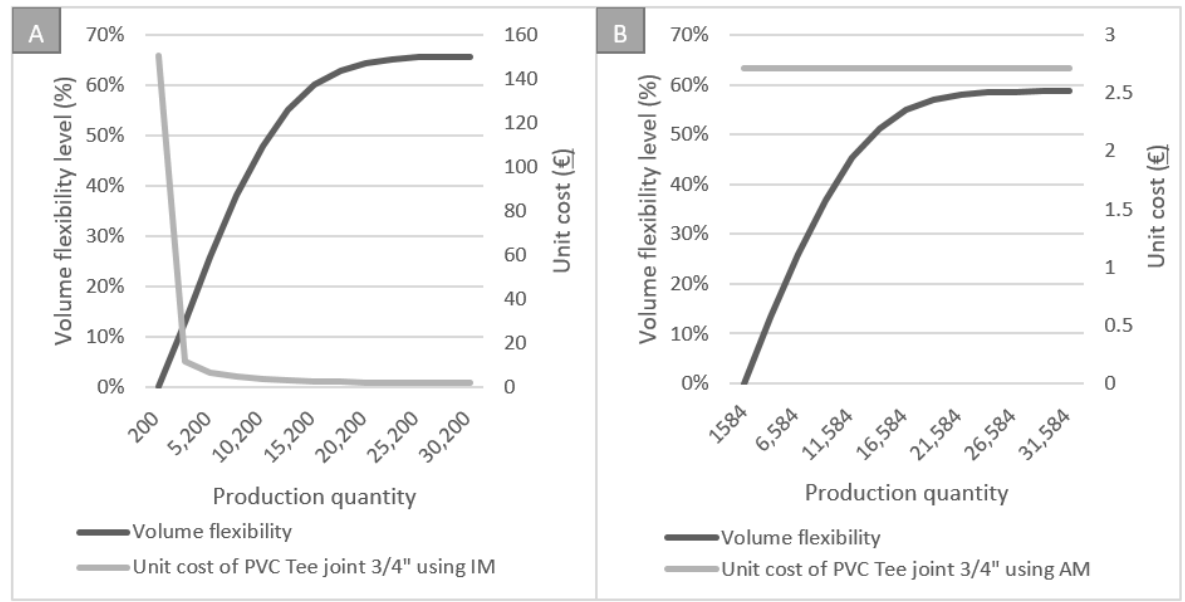
Figure 7. Relationship between volume flexibility and unit cost of the studied part for ( A ) IM and ( B ) AM.